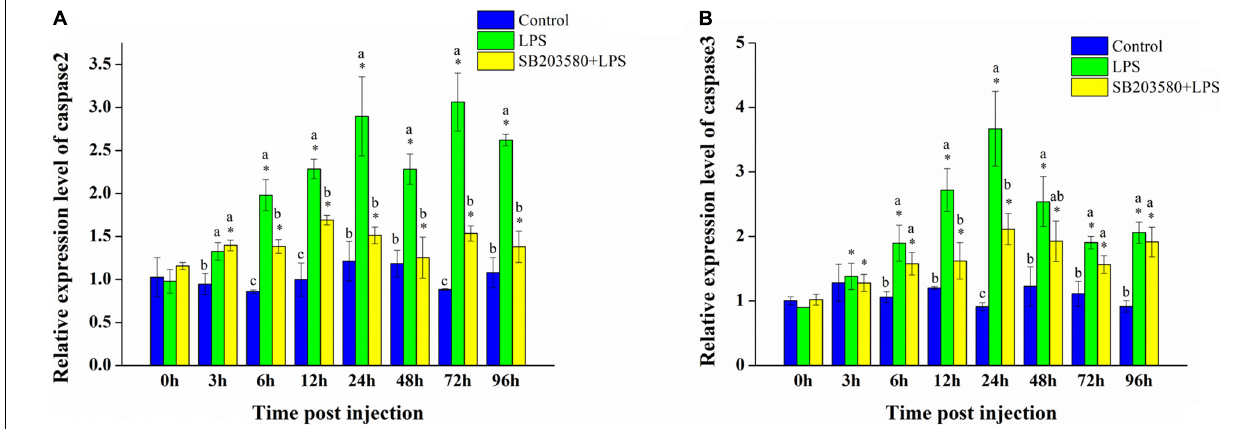
FIGURE 9 | Analysis of caspase2 and caspase3 gene expression in the hepatopancreas under LPS stimulation. (A) Analysis of caspase2 gene expression in the hepatopancreas under LPS stimulation. (B) Analysis of caspase3 gene expression in the hepatopancreas under LPS stimulation. Using GAPDH as an internal reference, the relative expression level of caspase2 in the control group at 0 h was set to 1. Error bars represent the SD of three independent repeats, and the results are expressed as means ± standard deviation. Independent sample t -test analyzed the significant changes at different time points in the same treatment group. *Indicates a significant difference between this time point with 0 h. Duncan’s multiple comparison test analyzed the significant changes between different treatments at the same time point. a, b, and c indicate significant differences between treatment groups. P < 0.05 was considered statistically